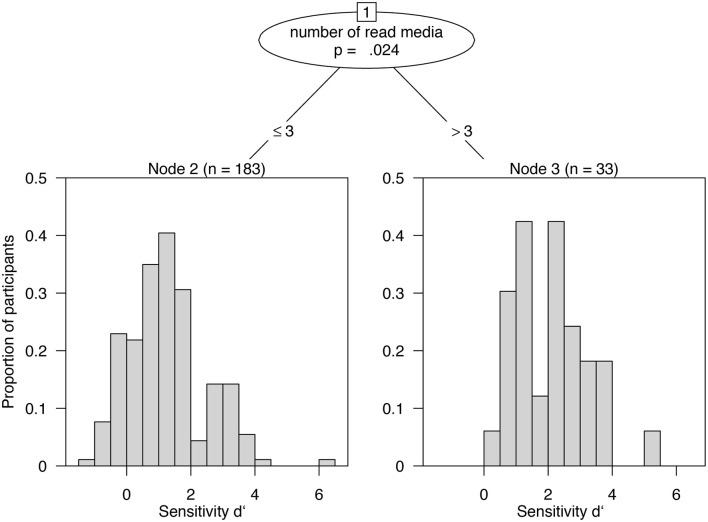
Regression tree for sensitivity d' as outcome variable. The only relevant predictor for high vs. low discrimination performance is the number of read media (≤3, >3).